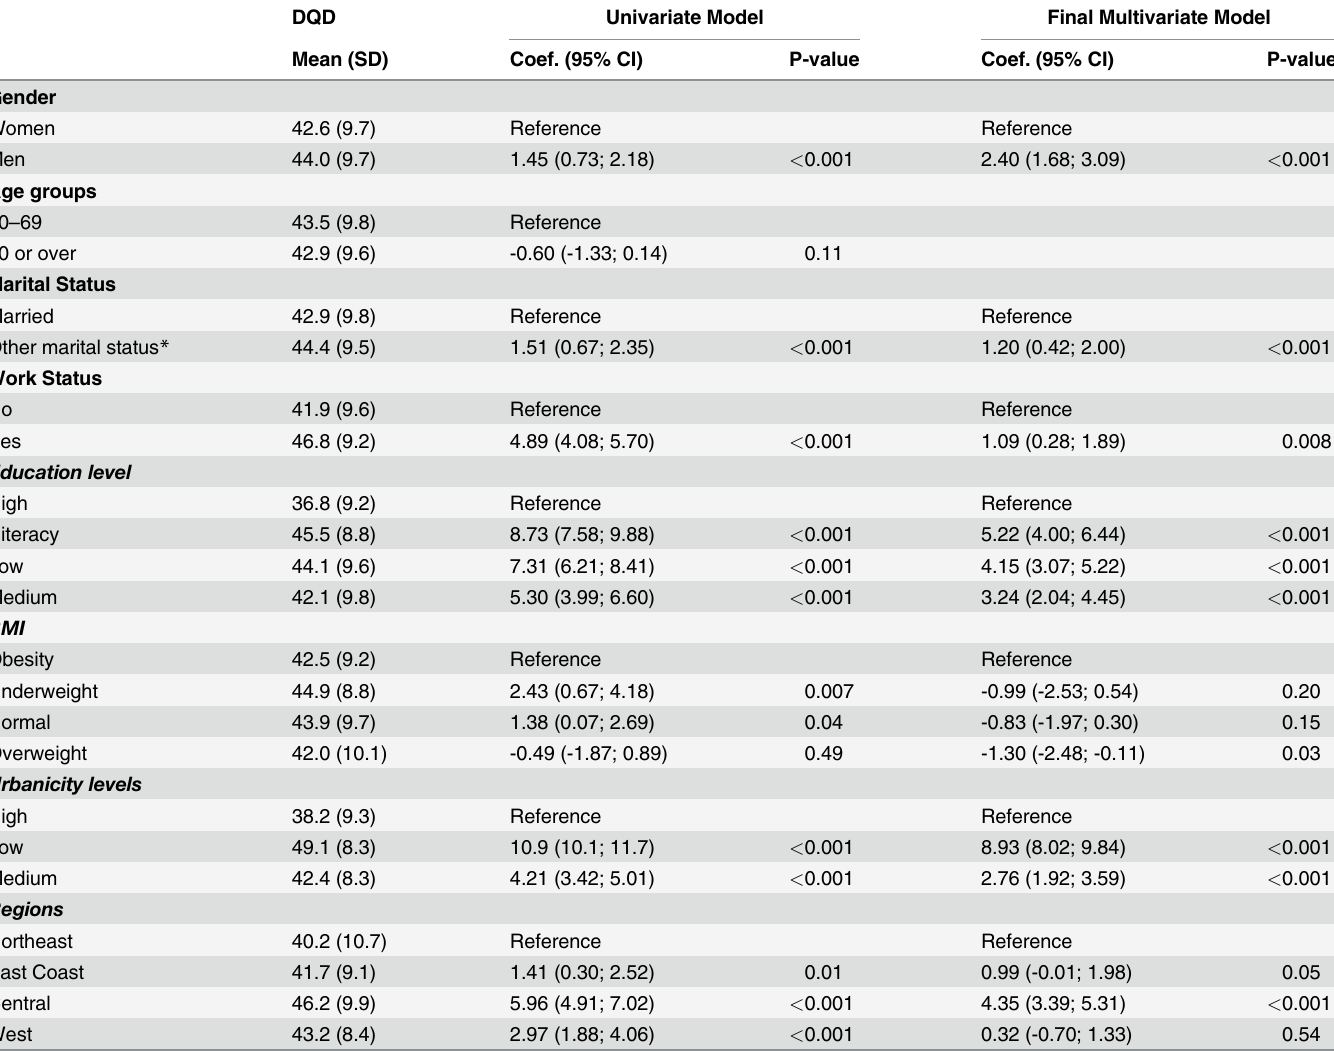
Table 5. Linear regression models for DQD, classified by predictor